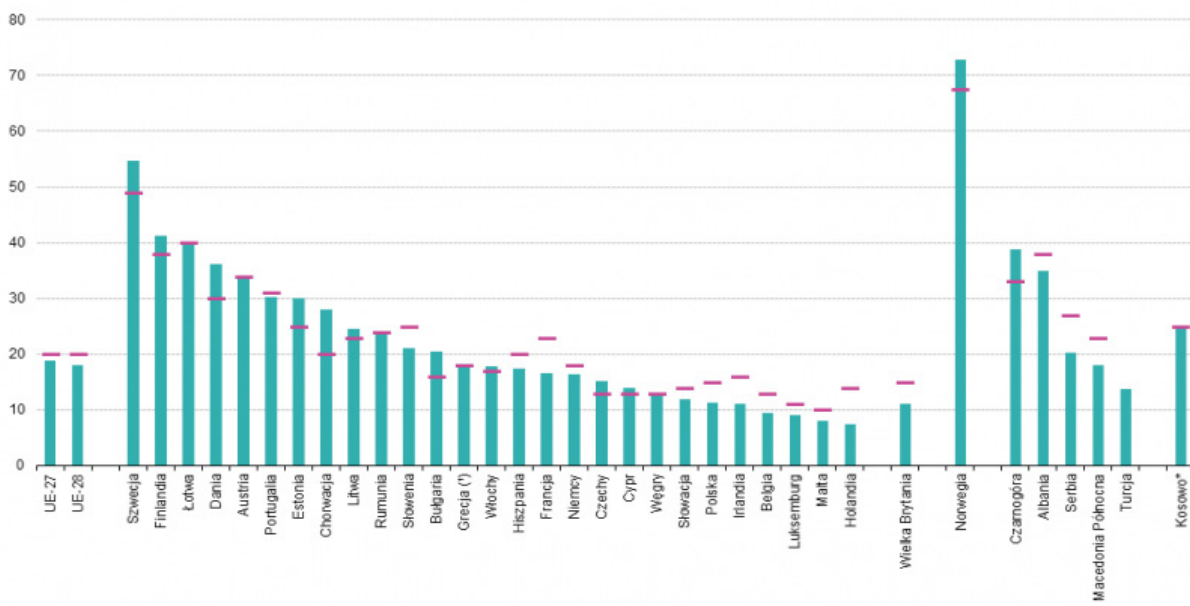
Figure 1: Share of energy from renewable sources, 2018 [1].